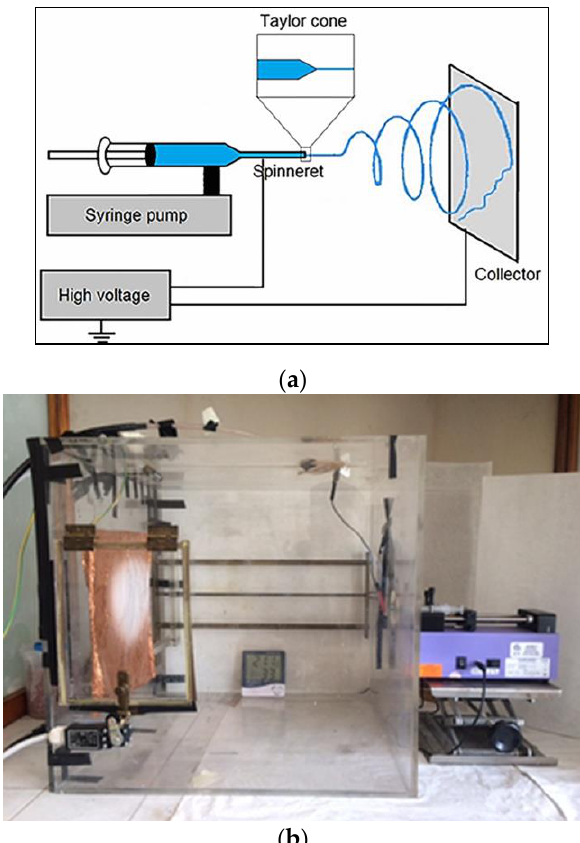
Figure 1. Electrospinning apparatus. ( a ) Schematic setup; ( b ) Laboratory setup.